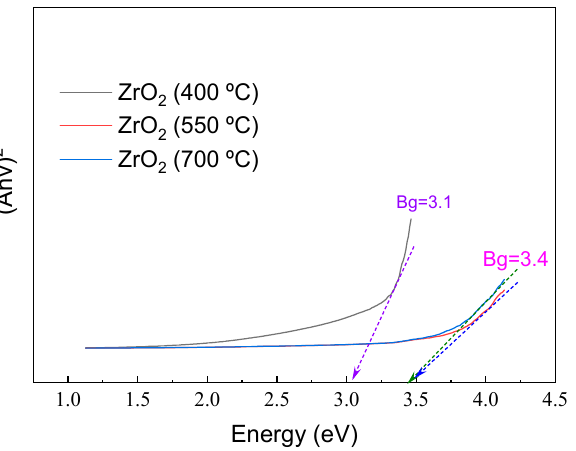
Figure 9. The Kubelka–Munk transformation of the diffuse reflectance spectrum for annealed ZrO 2 NTs.